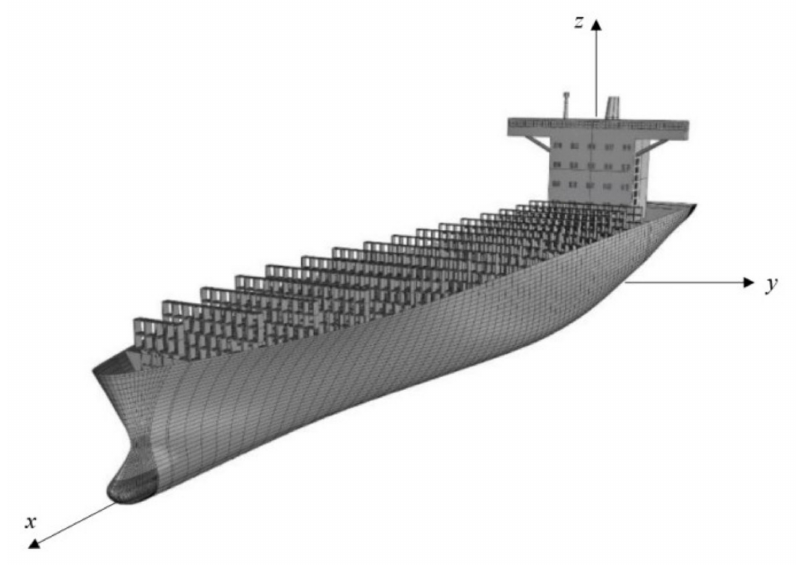
Figure 1. General overview of the 2400 TEU container